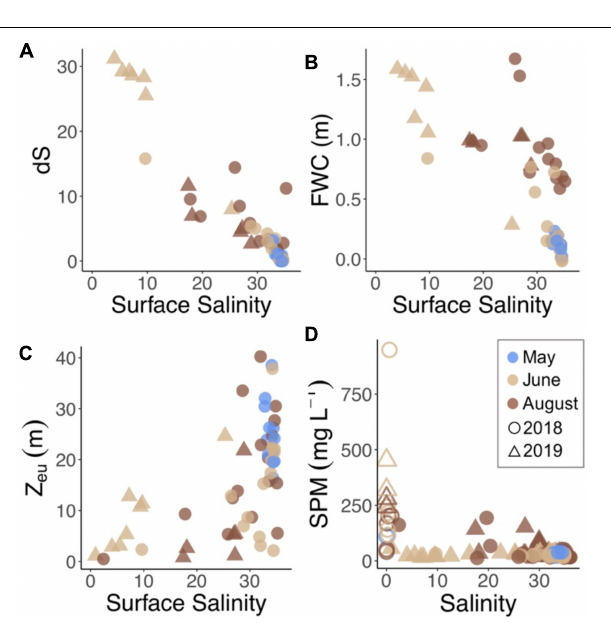
FIGURE 3 | (A) Difference in salinity (dS) between surface and 10 m, (B) fresh water content (FWC) between surface and 10 m, (C) depth of euphotic zone (Z eu ), and (D) suspended particulate matter (SPM) by year (symbol) and month (color). River samples are further distinguished by open symbols.